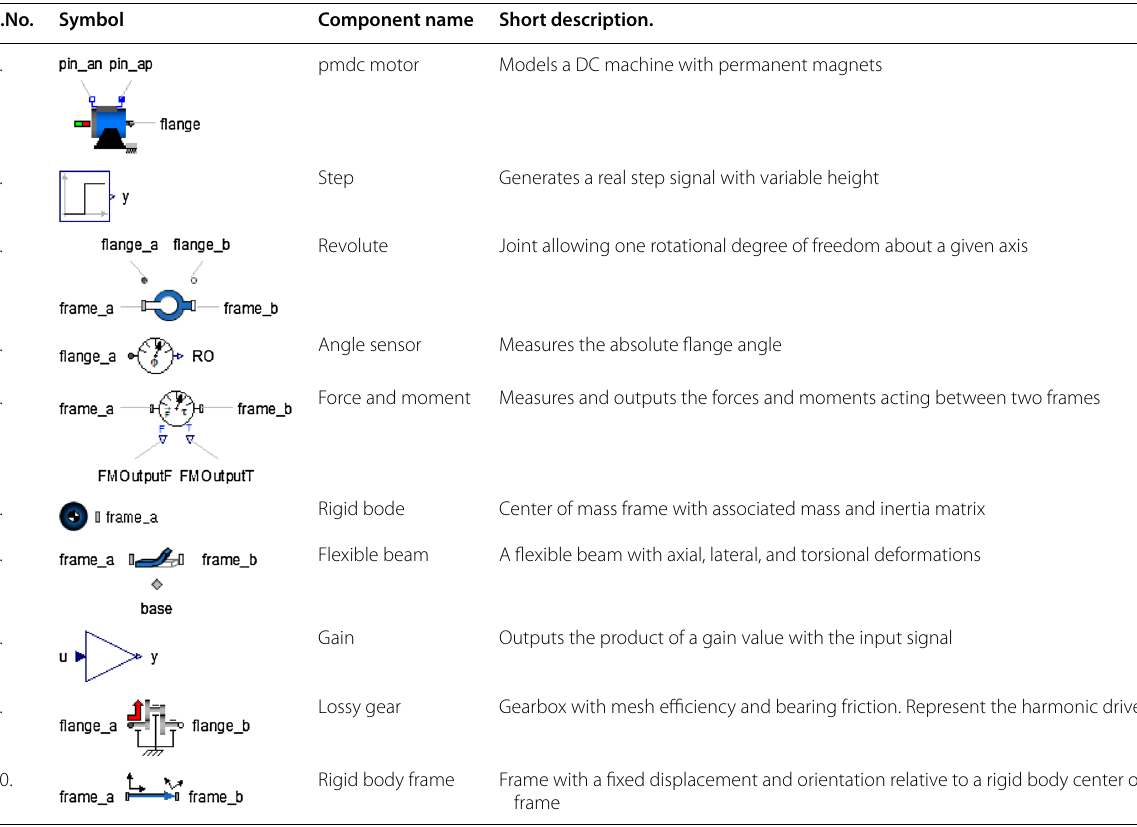
Table 1 Building block of the arm in Maplesim S.No. Symbol Short